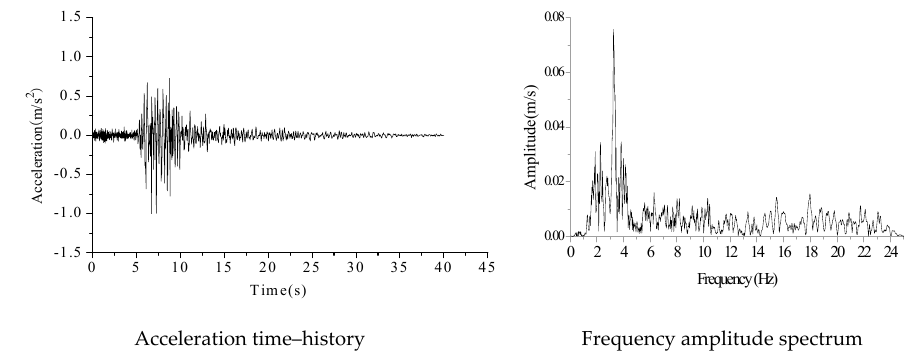
Figure 11. Taft motion in the horizontal direction after inversion.